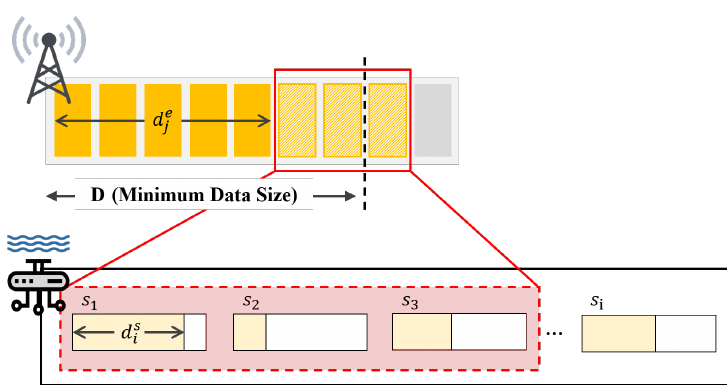
Figure 4. Optimally fair FL scheduling algorithm.